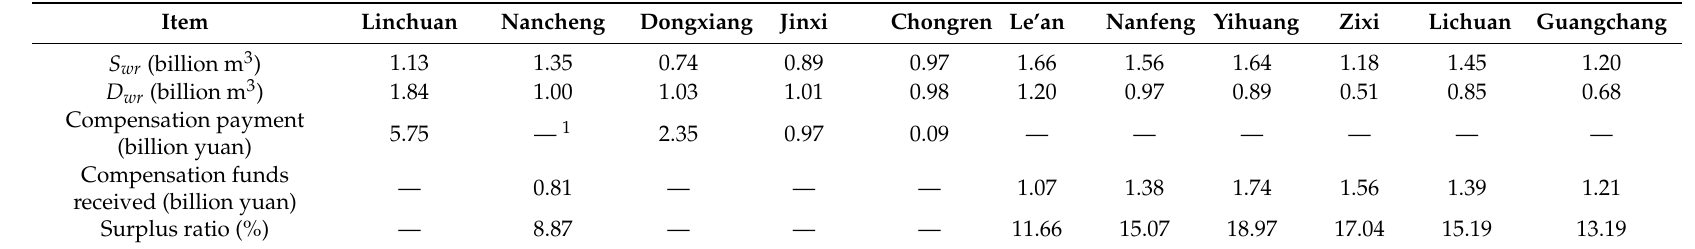
Table 3. Assessment of supply and demand for water conservation and the distribution of compensation funds. Item